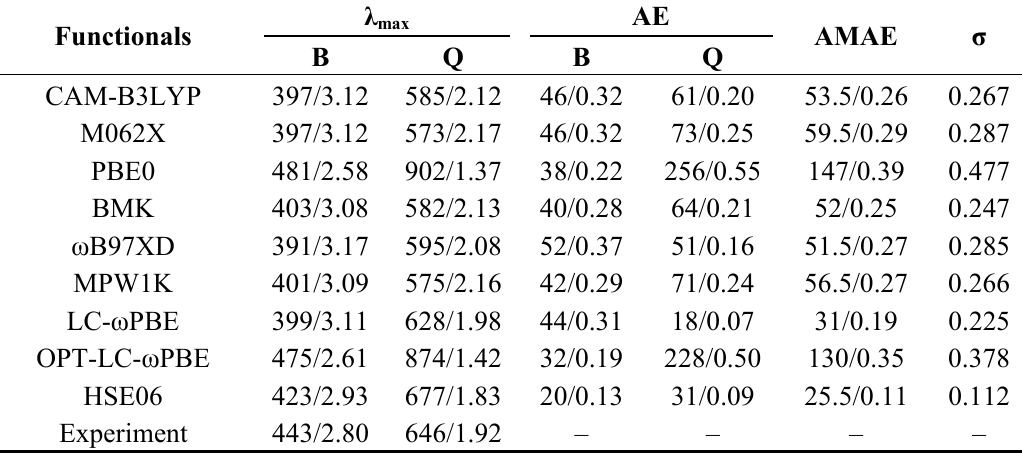
(in nm/eV) and the absolute errors (AE, in nm/eV) Table 1. The calculated absorption λ max of B and Q bands for YD2 with different functionals in TDDFT, the arithmetic mean absolute errors (AMAE, in nm/eV) and mean square error σ (in eV) are also